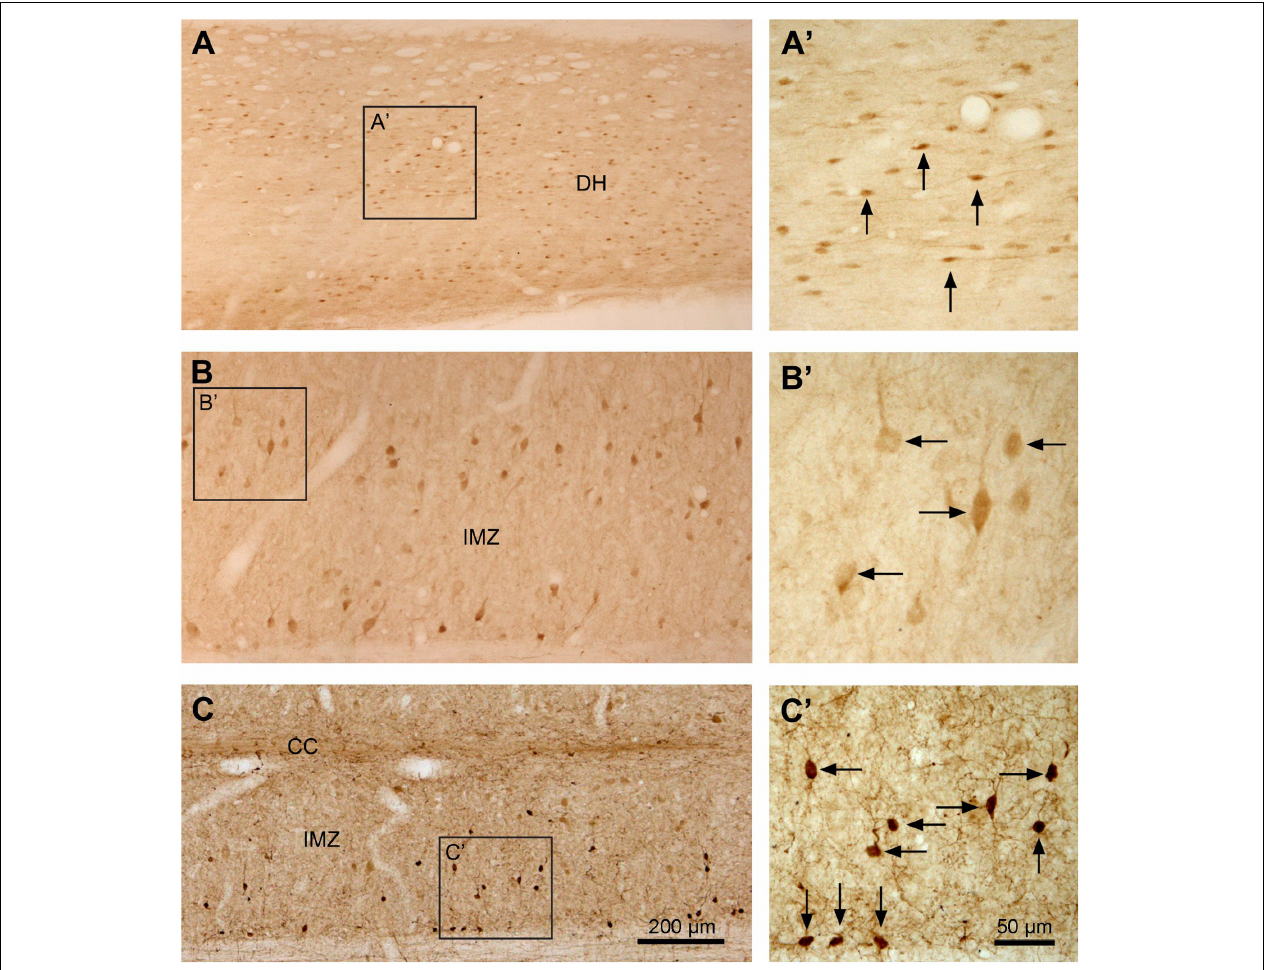
FIGURE 8 | Aromatic L -amino acid decarboxylase cell distribution in different regions of the spinal gray matter illustrated in horizontal sections. (A–C) Photomicrographs of low magnification showing the AADC cells in the superficial DH in L5 segment (A) , in the IMZ in the same segment (B) , and IMZ in S4 segment (C) . (A’–C’) are the enlargements of the squared regions in (A–C) , respectively. Note that the small fusiform- or spindle-shaped AADC cells in the superficial DH with their long axes oriented in the rostrocaudal dimension (A , A’) . In the IMZ in the L segment the AADC cells were larger and most of them had their long axes oriented mediolaterally (B , B’) . The AADC cells in the IMZ in the S segment were smaller and the long axes were oriented in different directions (C , C’) . Arrows indicate the representative AADC cells in different regions. Medial side is upward for (A,B) . AADC antibody was from rabbit. Scale bar in (C) , valid for (A–C) , 200 µ m; in (C)’ , valid for (A’–C’) , 50 µ